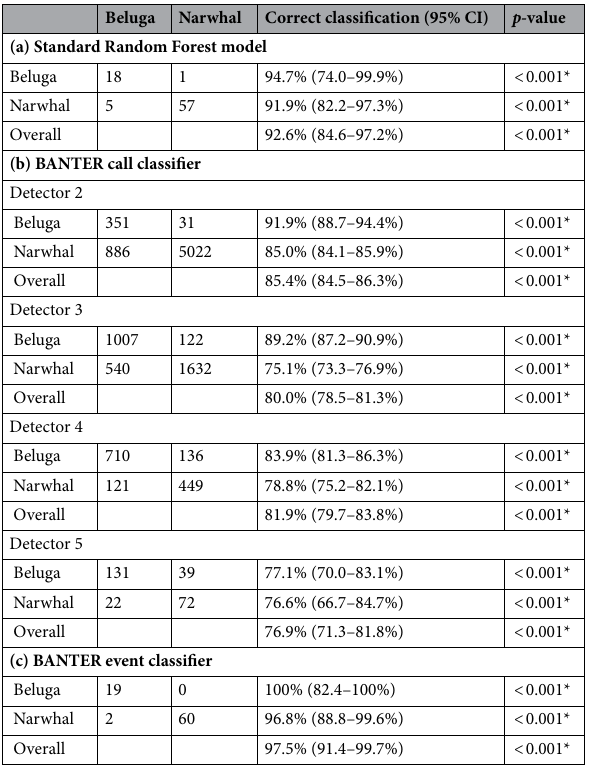
Table 3. Confusion matrices for the (a) standard Random Forest model, (b) BANTER call classifiers (Detectors 2, 3, 4, and 5), and (c) BANTER event classifier. The total number of correct and incorrect classifications are shown between the groups identified a-priori (rows) and predictions by the classifier (columns). Out-of-bag (OOB) percent correct classification rates (95% confidence interval) demonstrate model performance. Binomial test p -values using a prior probability of 0.5 are provided where an asterisk (*) represents statistical significance ( p <